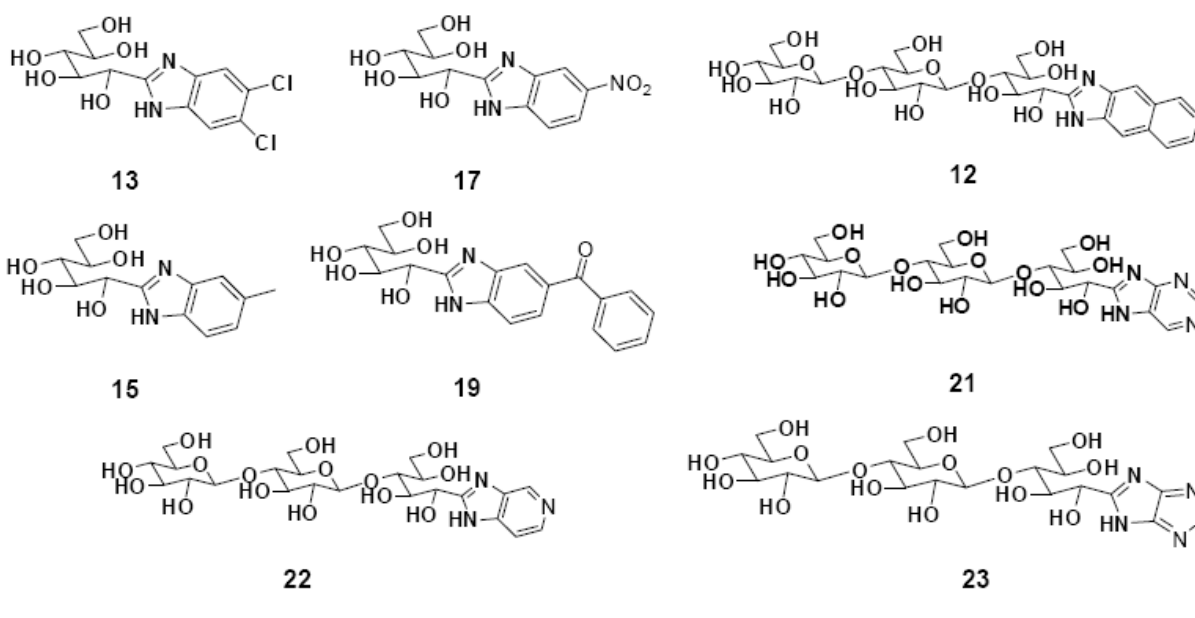
Figure 7. The compound list of synthesized aldo–IM